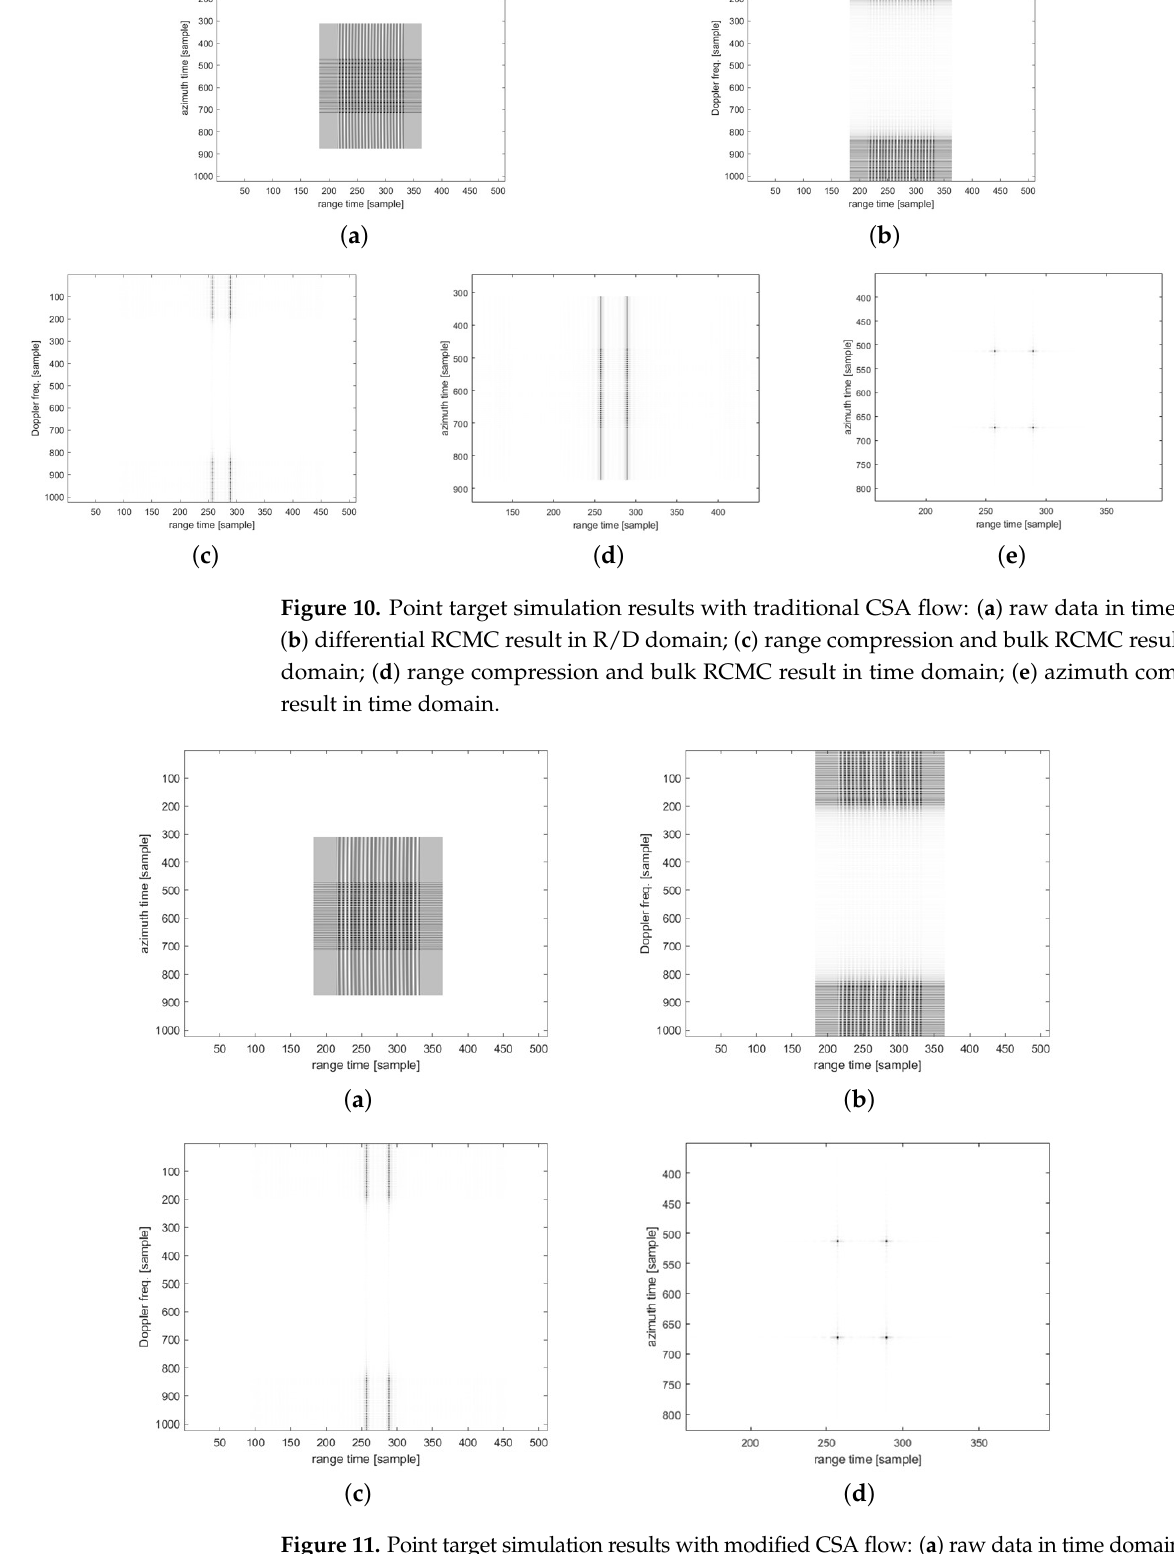
Figure 11. Point target simulation results with modified CSA flow: ( a ) raw data in time domain; ( b ) first block result in R/D domain; ( c ) second block result in R/D domain; ( d ) third block result in time